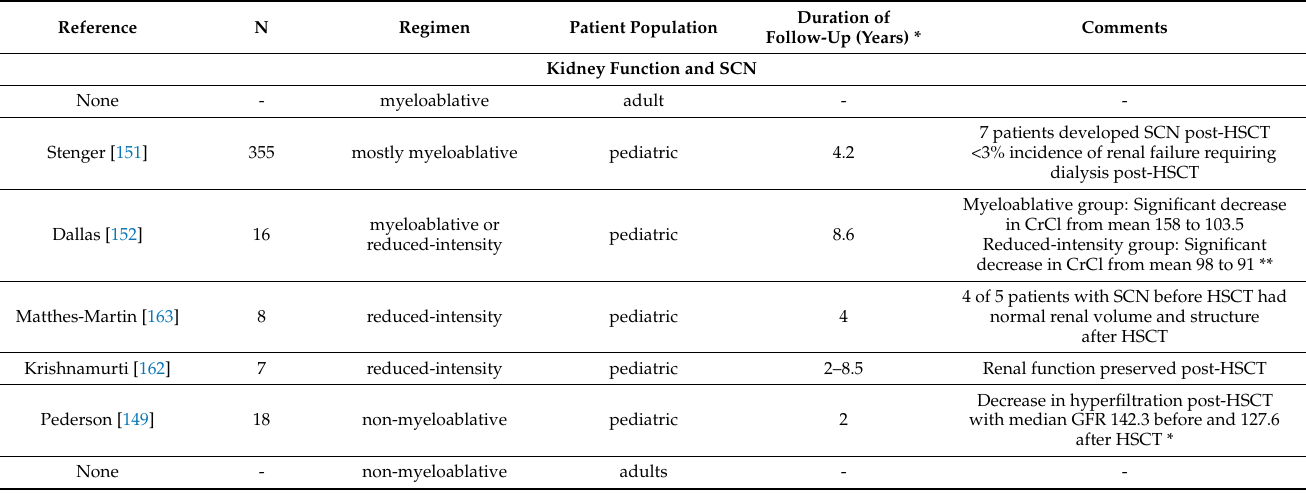
Table 4. Late effects studies evaluating kidney function and nephropathy in patients with SCD who receive